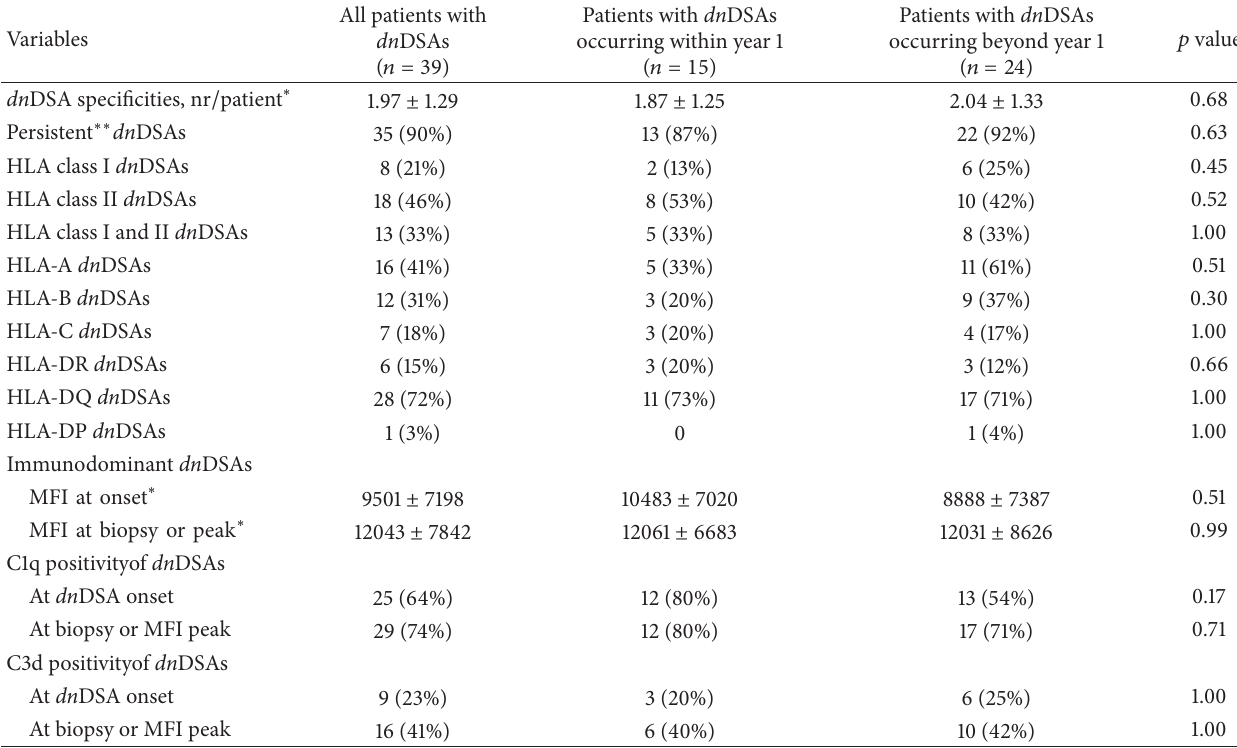
Percentages are calculated on the total number of patients from each group indicated at the top of the respective columns. All data are reported as absolute numbers, unless otherwise specified; ∗ data reported as mean ±